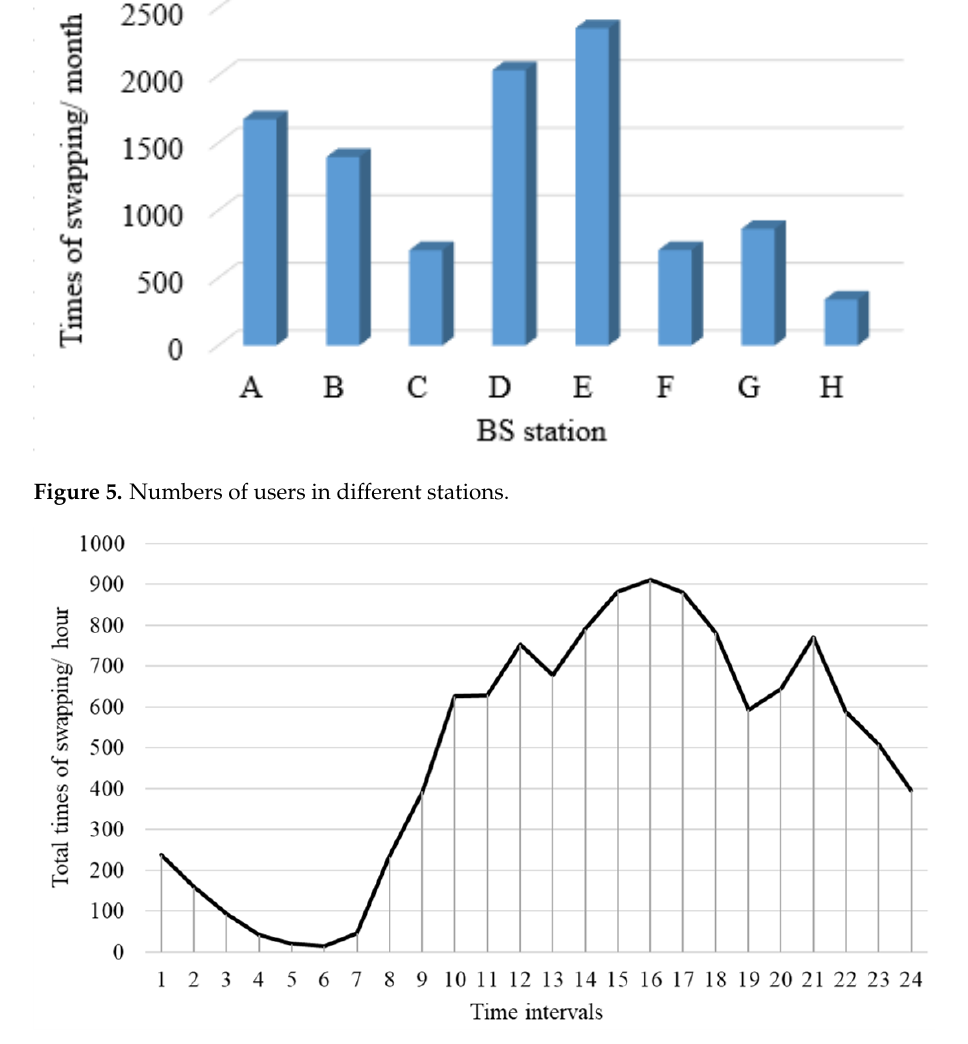
Figure 6. Changing demands during a